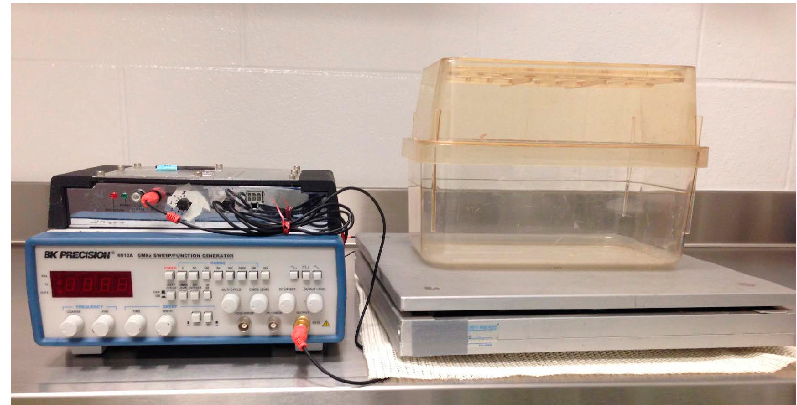
Figure 1. Equipment used to deliver whole-body low-intensity vibration (LIV) to mice. Mice were placed in an empty cage directly on the vibrating plate, and LIV was applied vertically at either 45 Hz or 90 Hz with a peak acceleration of either 0.4 g or 0.2 g for 30 min/day. The non-vibrated controls were similarly placed in a separate empty cage but were not subjected to LIV.